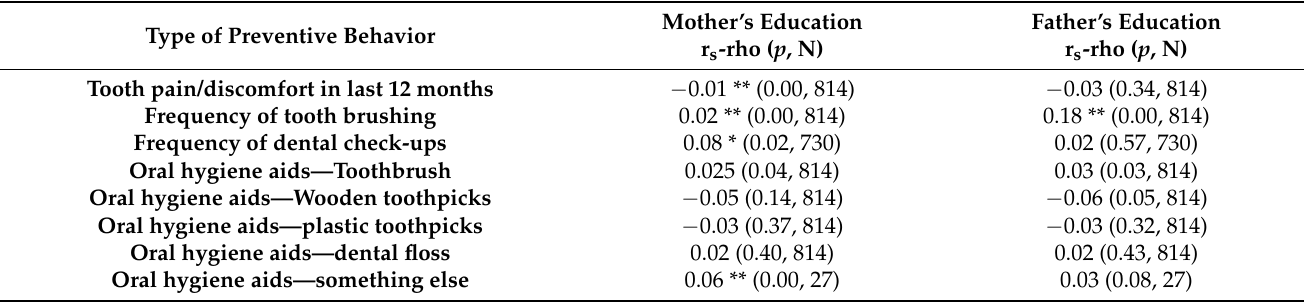
Table 3. Correlation between parent’s education and the preventive behavior.